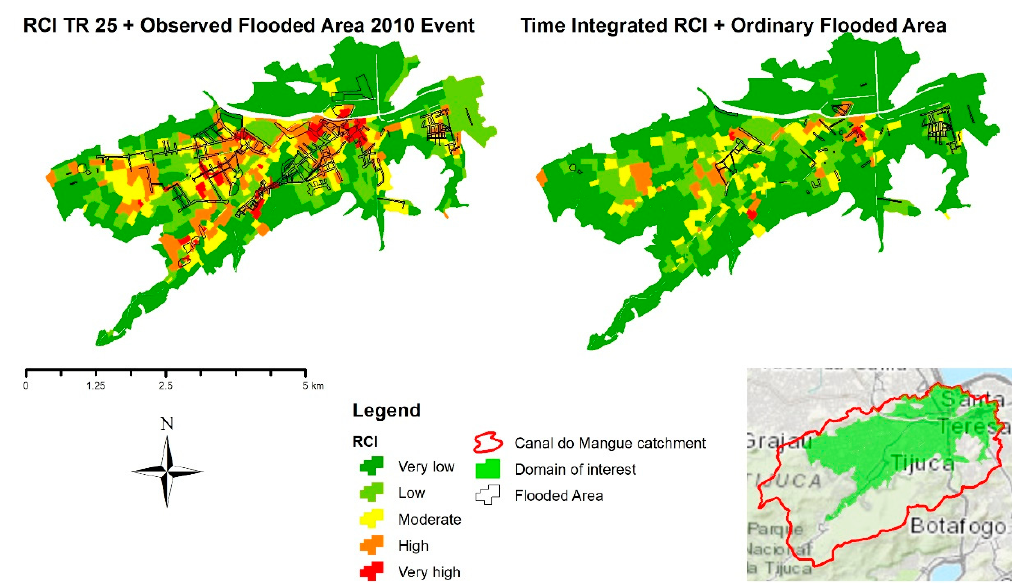
Figure 14. Comparative results of RCI RT 25 C0 and Time-integrated with flooded areas in the Canal do Mangue catchment.